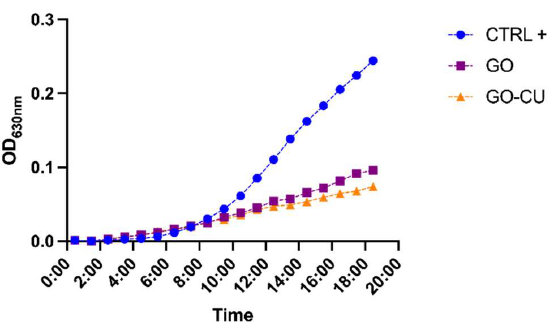
Figure 3. Growth curve of C. parapsilosis incubated with plastic (CTRL), GO, and GO/CU. O.D 630 was monitored every hour for 18 h.